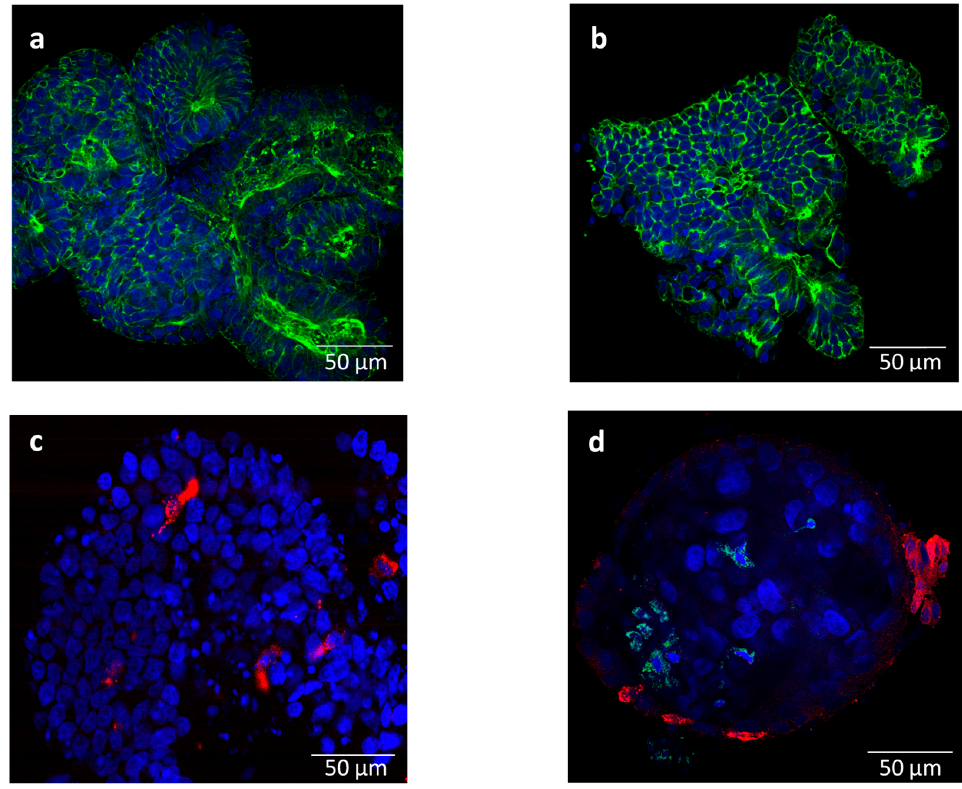
Figure 1. Representative immunofluorescent staining images of bovine enteroids ( a – c ) mock-infected and ( d ) infected with bovine coronavirus (BCoV) at 72 h post inoculation: ( a ) F-actin expressing brush border on the luminal surface (Phalloidin, green); ( b ) stained for enterocytes (sucrase isomaltase, green); ( c ) stained for enteroendocrine cells (chromogranin A, red); and ( d ) stained for BCoV S-protein (green) and enteroendocrine cells (chromogranin A, red). Nuclei were counter-stained with Hoechst (blue). Magnification = 63×; Scale bar = 50 μ m.